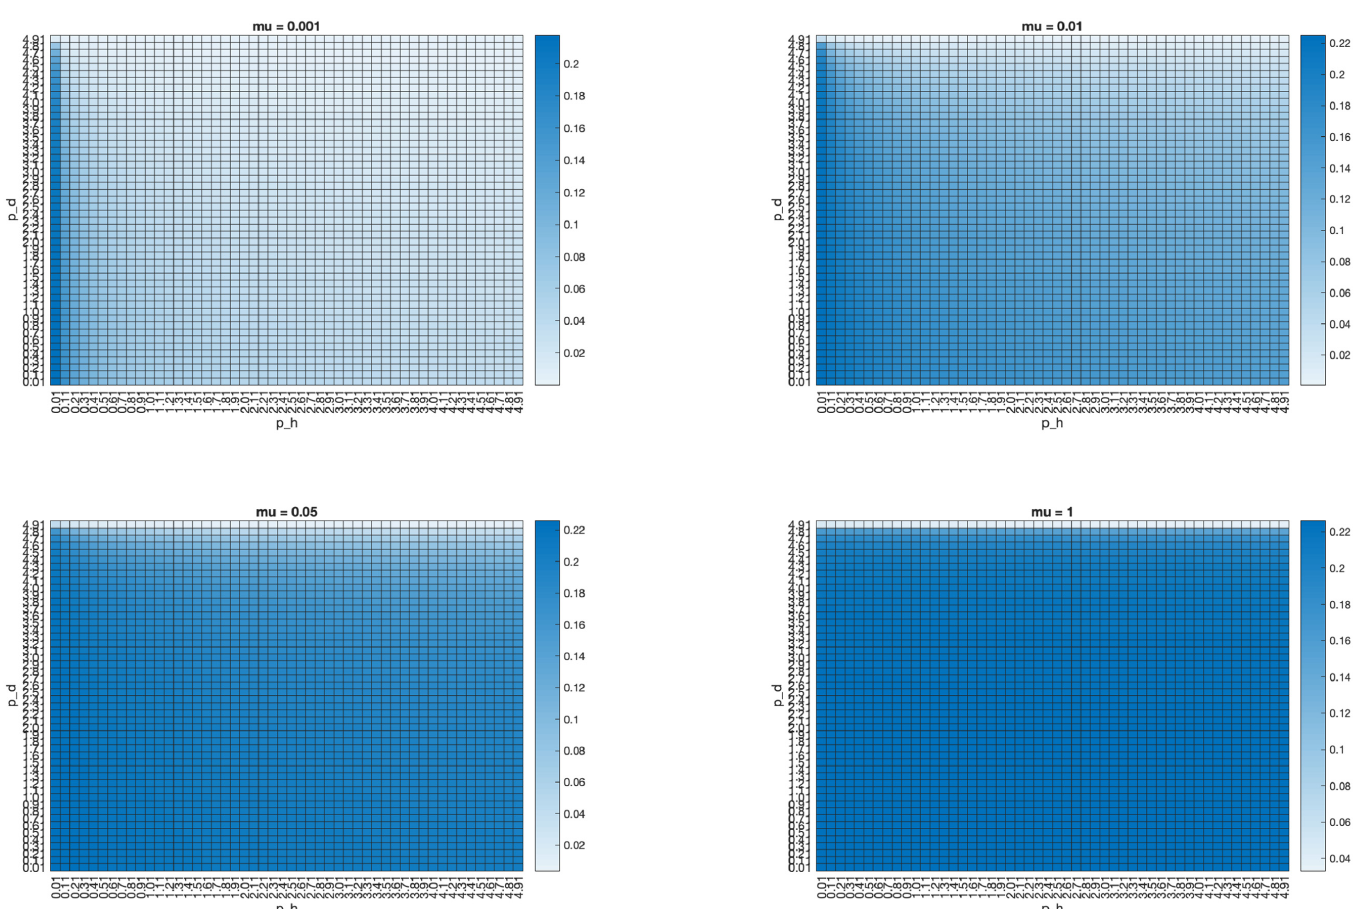
Fig 5. Graphing the equilibrium proportion of infected humans ( I h ) against p h and p d for four different values of μ , with β h = 0. Parameters are as in Table 5, with β w = β = 0.118 � 5. While intracompartmental reproductive numbers vary between simulations, R 0 for all four simulations is 2.2463. d